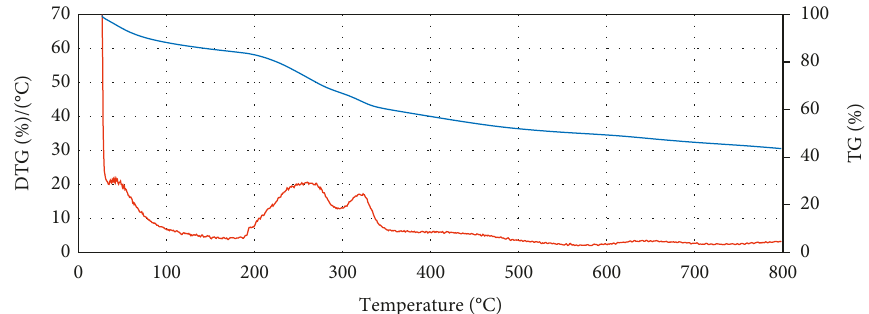
Figure 8: TGA curve and DTG curve for Ceramium rubrum sample under N